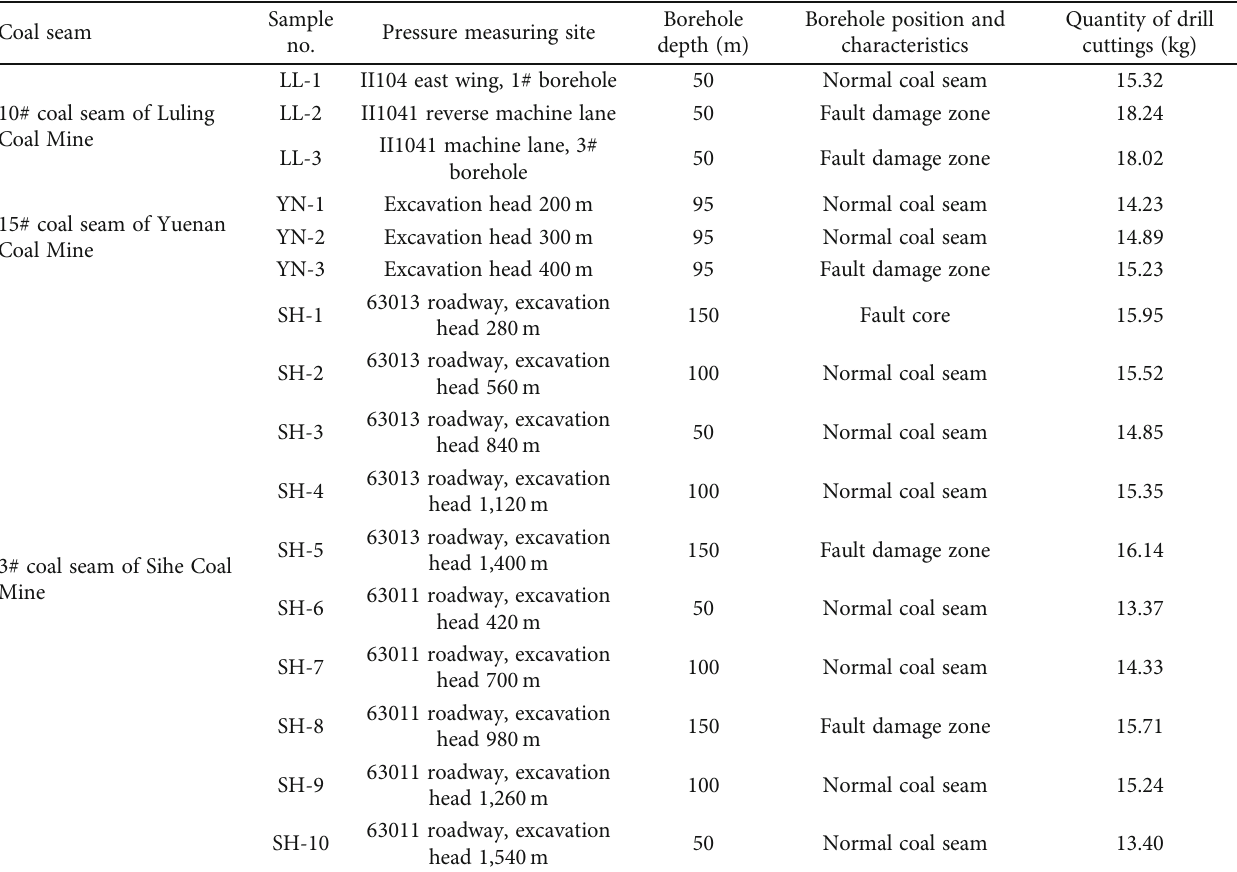
Figure 3: Sampling site. Table 1: Drilling completion parameters at sampling